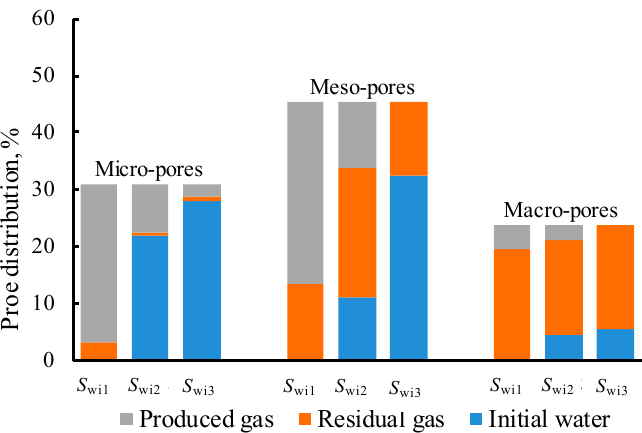
Figure 5. The pore distribution of initial water, residual gas and produced gas in micro-, meso- and macro- pores in spontaneous imbibition experiments of sample #1-1F at different S wi .